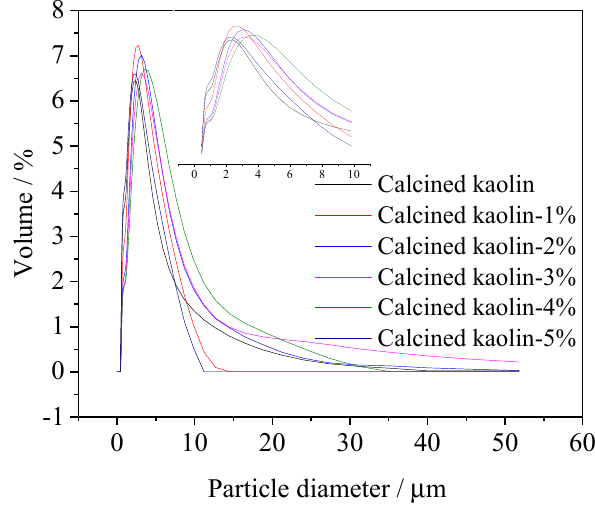
Figure 12. Particle diameter distribution of sample before and after modification.